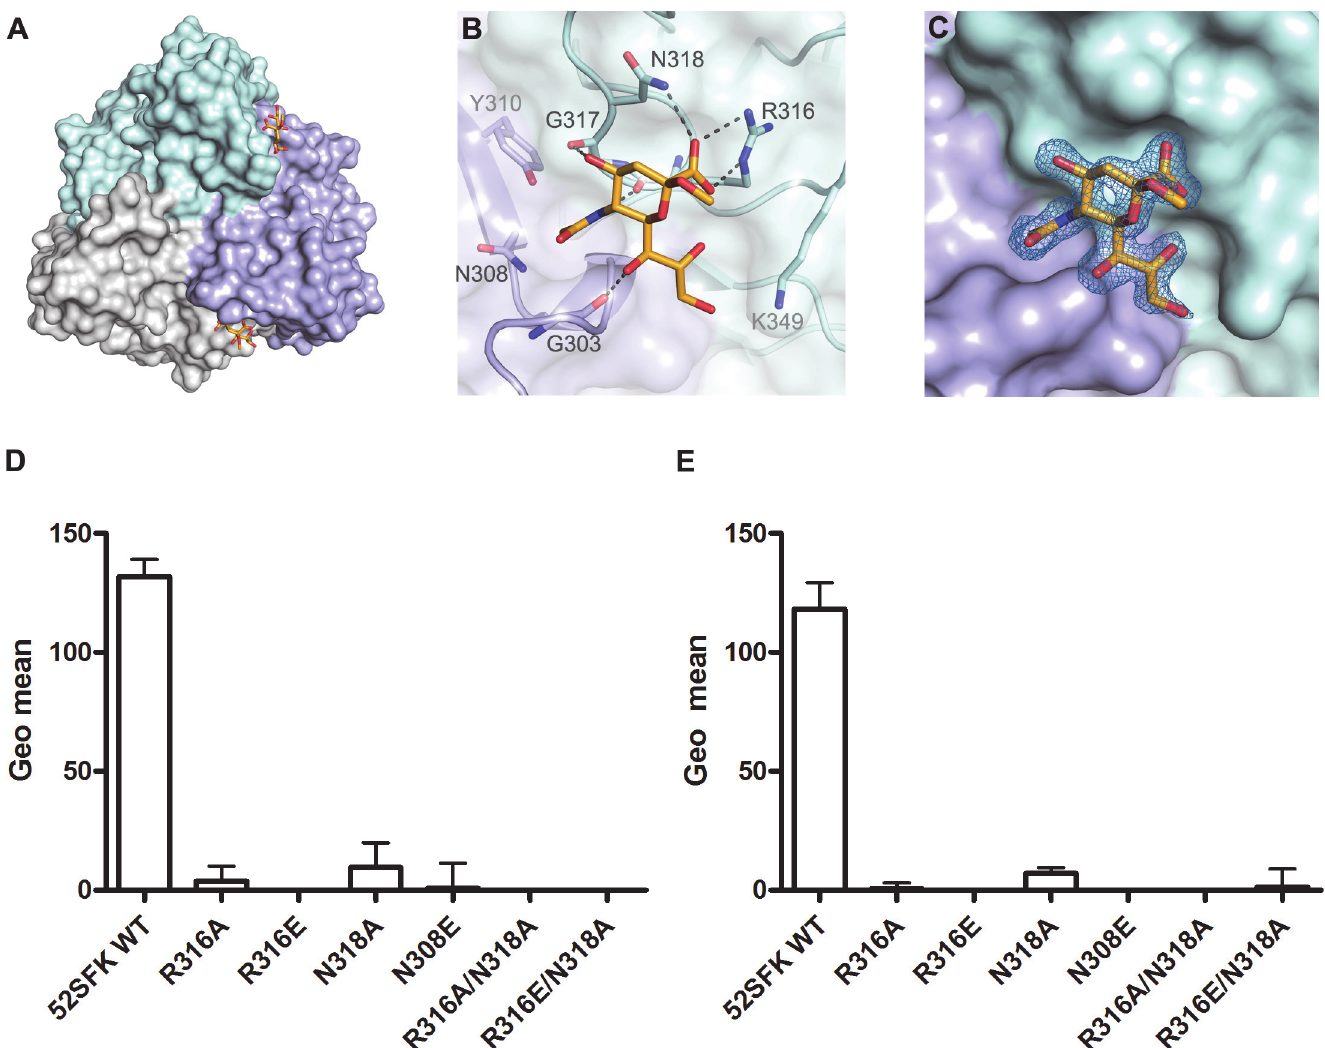
Fig 7. HAdV-52 interaction with sialic acid. (A) Surface representation of the HAdV-52 short fiber knob structure viewed from the top along the three-fold symmetry axis. The three monomers are shown in green, blue and grey. The 2- O -methyl sialic acid bound to two of three binding sites is shown as orange and red stick model. (B) Detailed view of the interactions in the ligand binding site. The side chain of R316 forms a bidentate salt bridge with the carboxyl group of sialic acid. Residues G303, R316 and G317 form backbone hydrogen bonds with the glycerol, amide and O4 groups of the sialic acid, respectively, while the side chain of N318 engages in a hydrogen bond with the sialic acid carboxylate. The methyl group is not involved in binding contacts. (C) Simulated annealing Fo-Fc omit map for the sialic acid. The map was calculated at 3.0 σ and is displayed with a radius of 1.7 Å around the ligand. 52SFK WT (wild type) and mutant binding to Pro5 (D) and A549 (E) cells. All experiments were performed three times with duplicate samples in each experiment. Error bars represent mean ± SD. * P of < 0.05, ** P of < 0.01 and *** P of < 0.001 versus